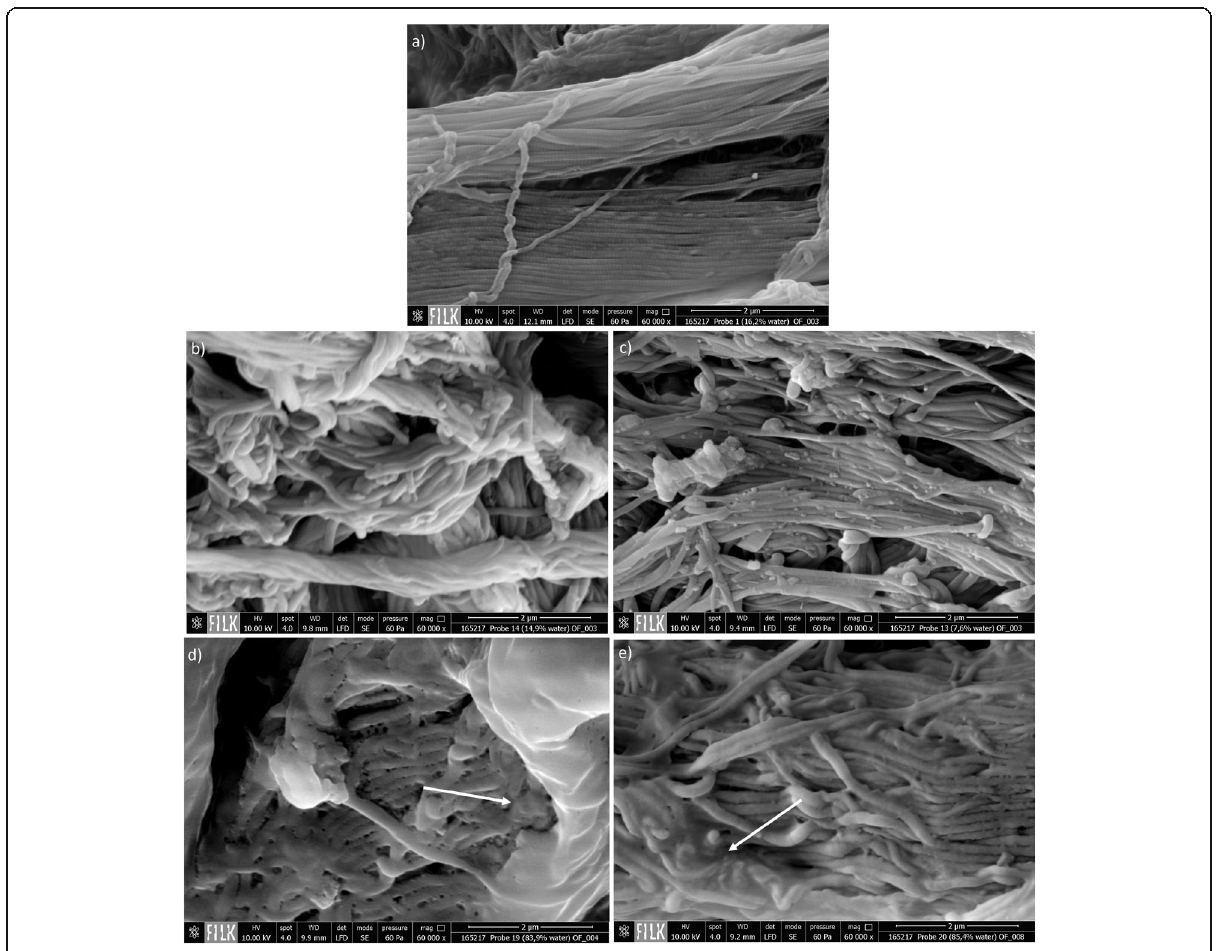
Fig. 1 SEM images of CS ( a ), E100D ( b ), E100W ( c ), H150 ( d ), H170 ( e ) (60,000×